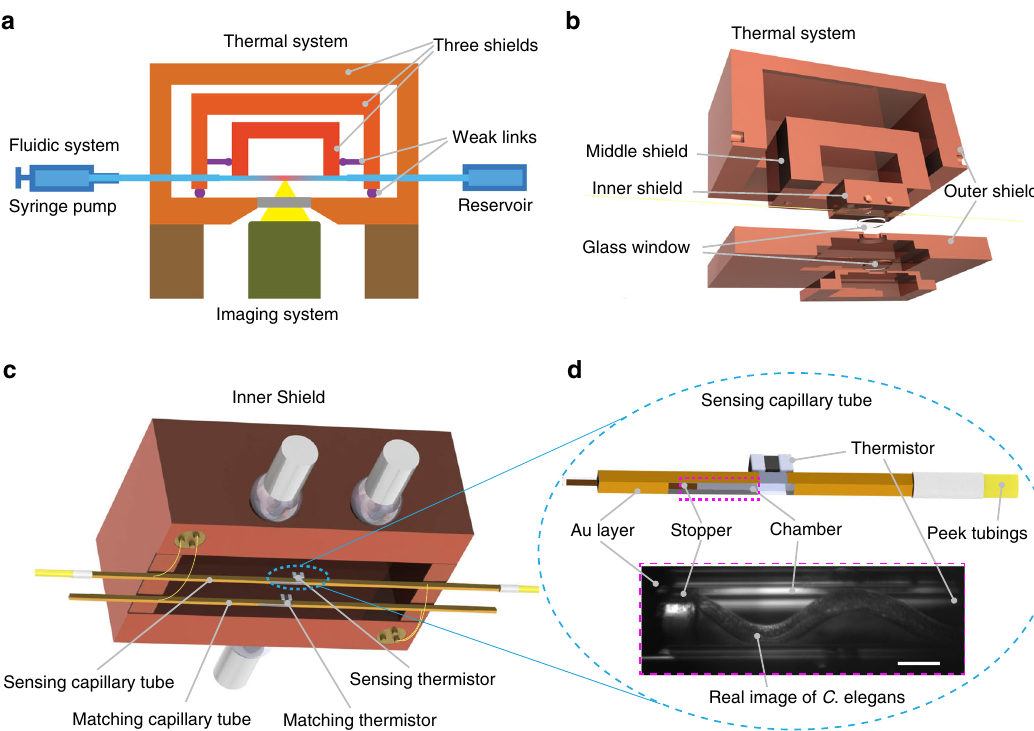
Fig. 1 Experimental setup. a Schematic depicting the three subsystems in our calorimeter: the fl uidic system (shaded in blue) with the syringe pump and reservoir for sample handling, the optical imaging system (green) focused to the center of the capillary tube and the thermal system involving the three shields with weak thermal links (between OS and MS, MS and IS shown in purple) mounted on the microscope stage. b Detailed isometric expanded view of the thermal system showing the assembly of all components. c Illustration of IS assembly (not to scale) showing two capillary tubes, the sensing capillary with a PEEK tubing assembly and the matching capillary, with respective thermistors connected in a Wheatstone bridge con fi guration to extract differential thermal signal. d Magni fi ed view of the marked area in c , depicting the capillary tube coated with gold on all four sides, except for the central region, where the C. elegans is localized, and instrumented with a thermistor to record the temperature. A borosilicate stopper traps the C. elegans in the center of the sensing capillary tube. A CCD image (marked in magenta dashed line) of a trapped C. elegans during a reference measurement shows the corresponding stopper and Au layer. Images were reproducibly taken every second during the measurement. Scale bar: 100 μ